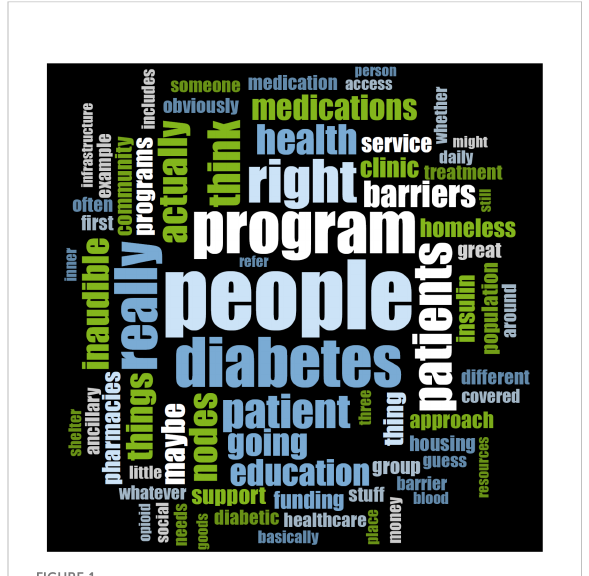
FIGURE 1 Word cloud illustrating most commonly used